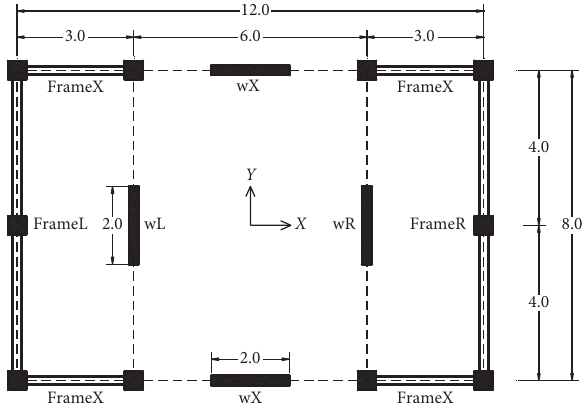
Figure 1: Arrangement of resisting elements in the